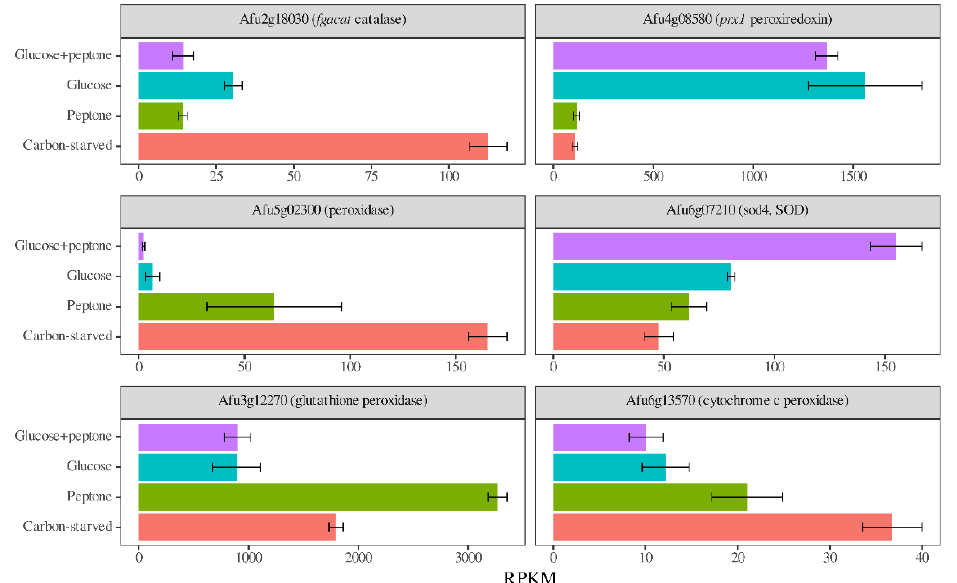
Figure 6. Effects of peptone and glucose withdrawal on the transcriptional activity of selected genes encoding antioxidative enzymes in Aspergillus fumigatus Af293. RPKM values generated from the RNAseq experiments (mean ± SD; n = 3) are presented.